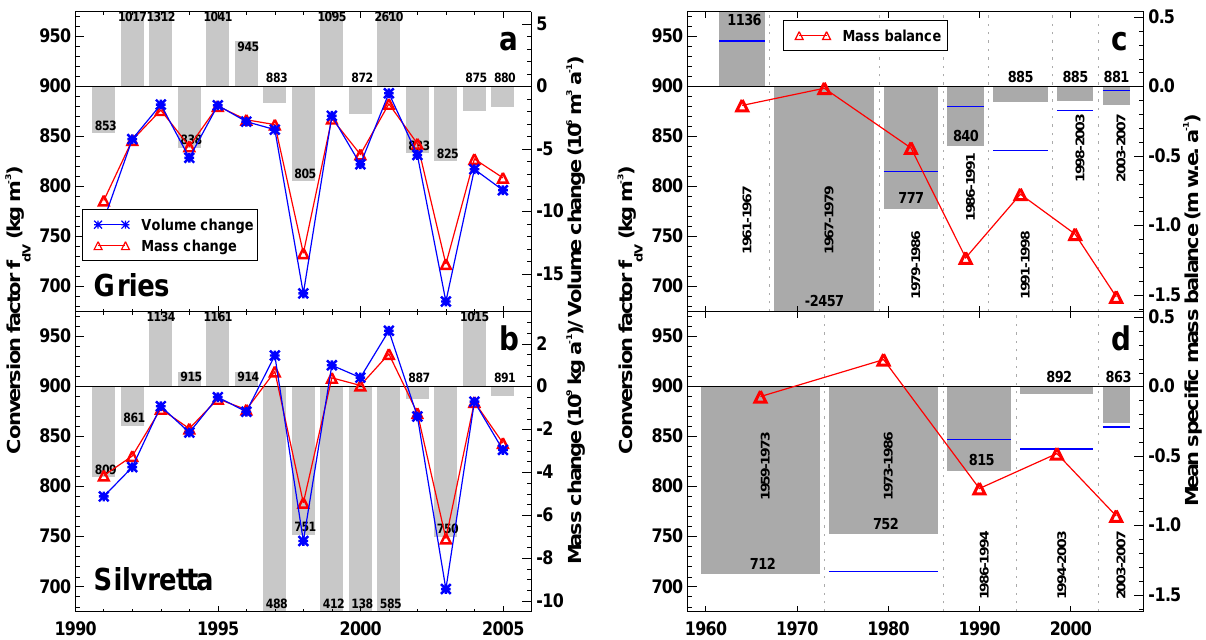
Fig. 5. Annual series of observed mass change and calculated volume change between 1990 and 2005 for (a) Griesgletscher and (b) Silvrettagletscher. The conversion factor f 1V for each year’s volume change is shown by bars. Note that for bars beyond the plotted range, values are stated. (c) , (d) f 1V for Gries and Silvretta over period lengths of 4–14yr corresponding to the dates of DEMs, and observed mean specific mass balances as period averages. Blue lines show f 1V, zonal estimated assuming zonally separated “densities” of volume change (see e.g. Moholdt et al.,